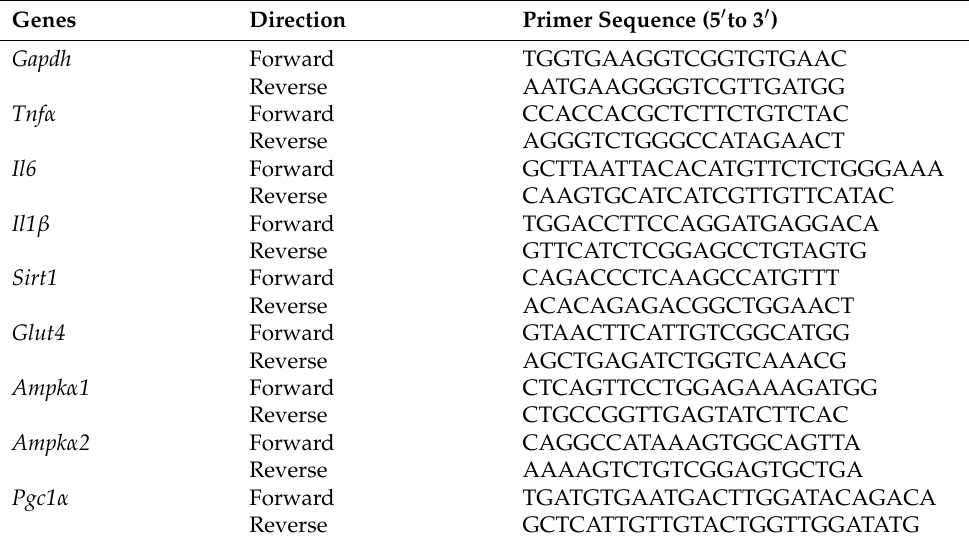
Table 1. Primers list for